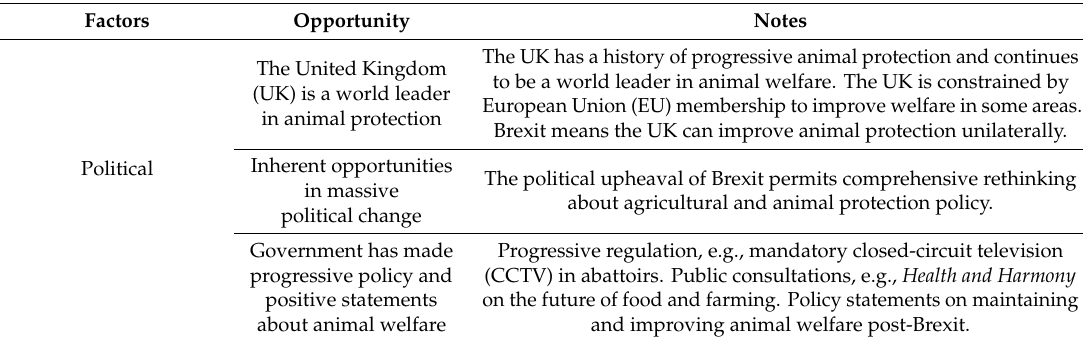
Table 1. Summary of opportunities for animal protection presented by